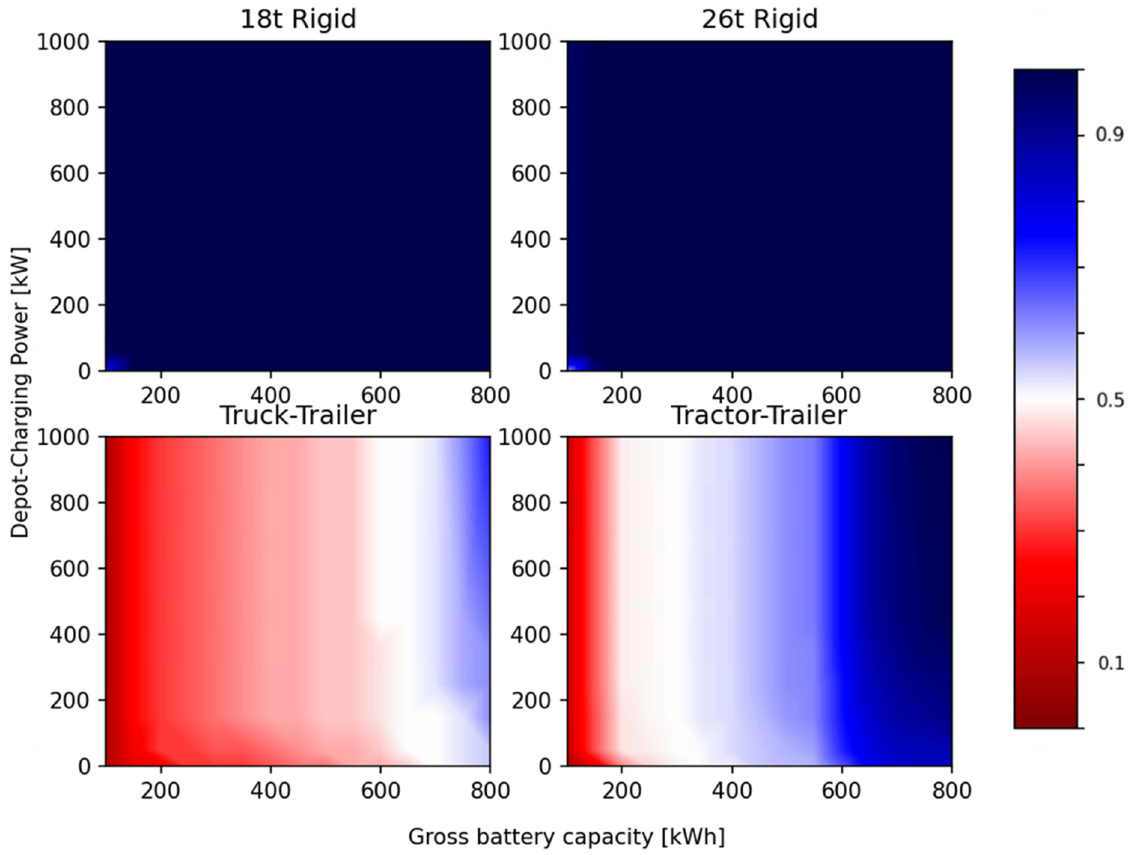
Figure 8. BET feasibility per truck class—scenario 2. Variations for battery capacity [kWh] and depot-charging power [kW] plus charging at retail stores (fixed, 150 kW; color bar indicates technical feasibility from 0% to 100% —own illustration.